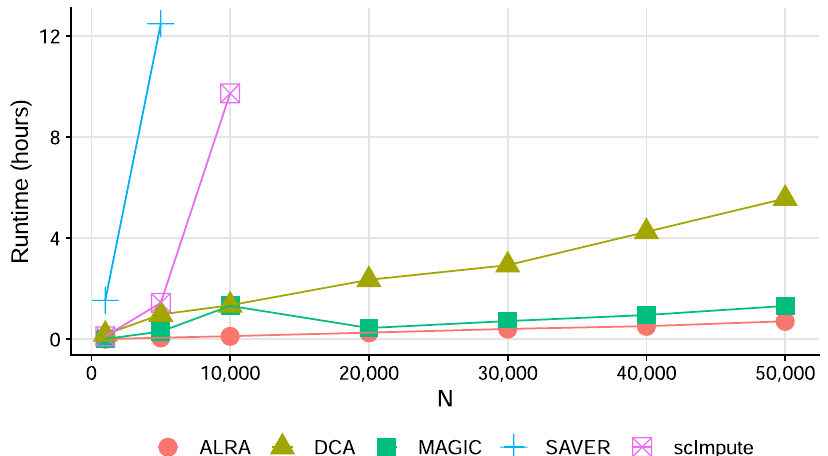
Fig. 4 Runtime of ALRA versus other imputation methods using expression matrices of N cells and ~19,000 genes. All experiments performed on a